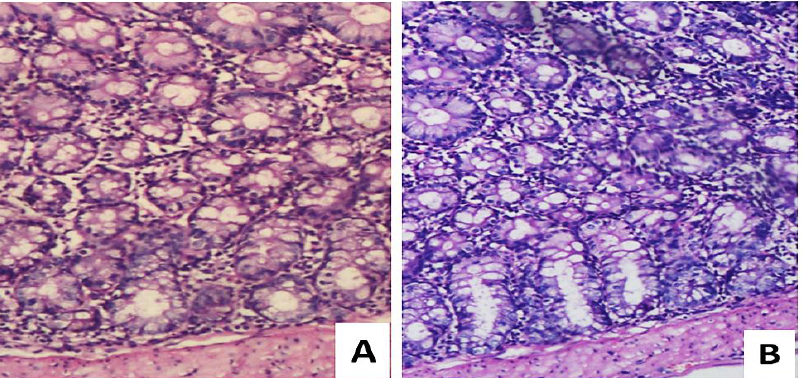
Figure 11. Microscopic study of hematoxylin and eosin (H&E) staining of colon tissue samples. ( A ) Control group; ( B ) Lactobacillus fermentum NMCC-14-treated group. Compared to the control, pro-